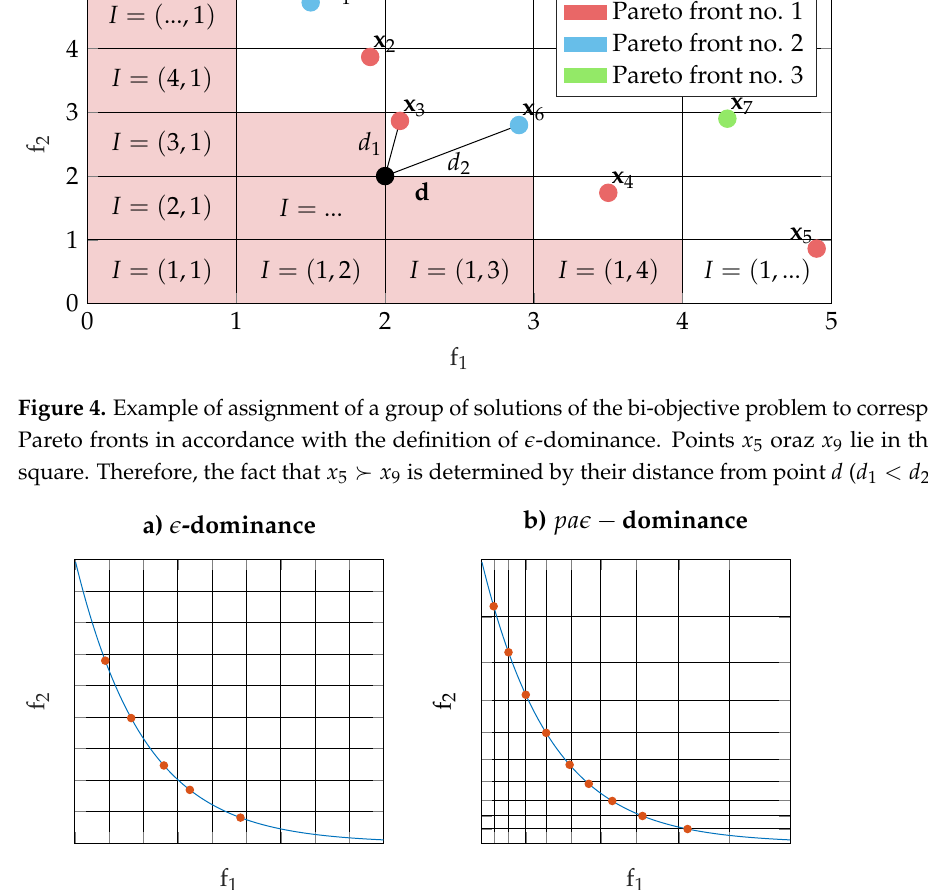
Figure 5. Example of division of the objective space of a bi-objective problem, with the Pareto front marked with a blue line, into: ( a ) uniform areas in accordance with (cid:101) − dominance; ( b ) areas with variable dimensions determined according to pa (cid:101) -dominance. The blue line marks the ideal Pareto front for a certain bi-objective problem. The red dots are points which belong to the front and are, at the same time, not dominated in accordance with the selected algorithm of division into areas